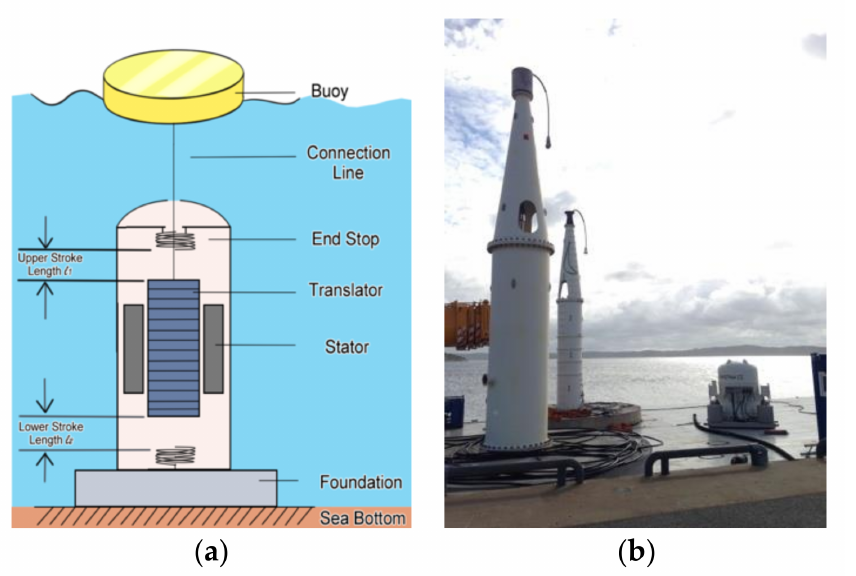
Figure 3. The wave energy converter (WEC) invented in the Uppsala University (UU) Project: ( a ) conceptual illustration of the point absorber type WEC; ( b ) the full-scale linear generators ready to be deployed at the Lysekil test site